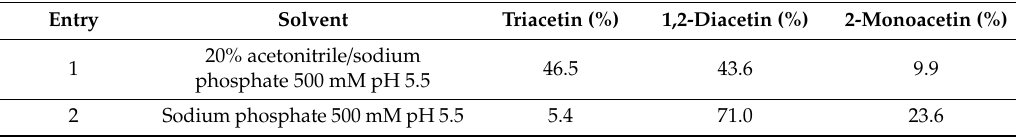
Table 1. E ff ect of solvents on the triacetin hydrolysis with Table 1. Effect of solvents on the triacetin hydrolysis with CALB-OC.